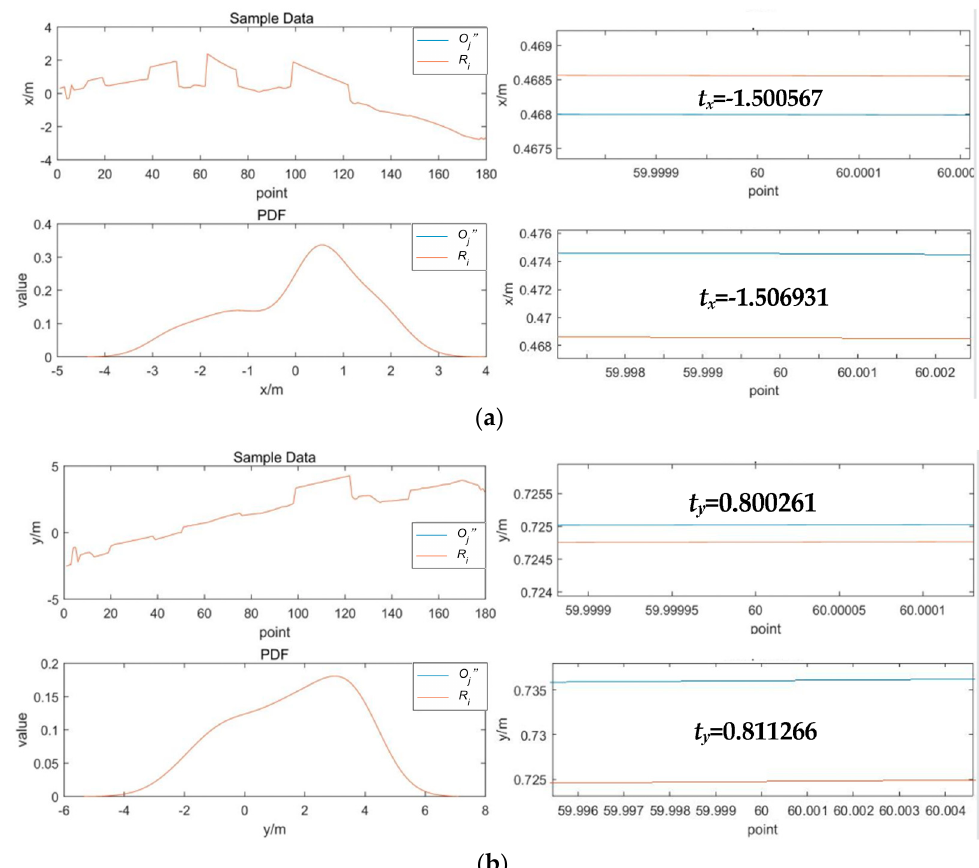
Figure 12. Sample data distribution and probability density function of data sets 𝑂 (cid:3037)’’ and 𝑅 (cid:3036) : ( a ) x-axis; ( b ) y-axis.